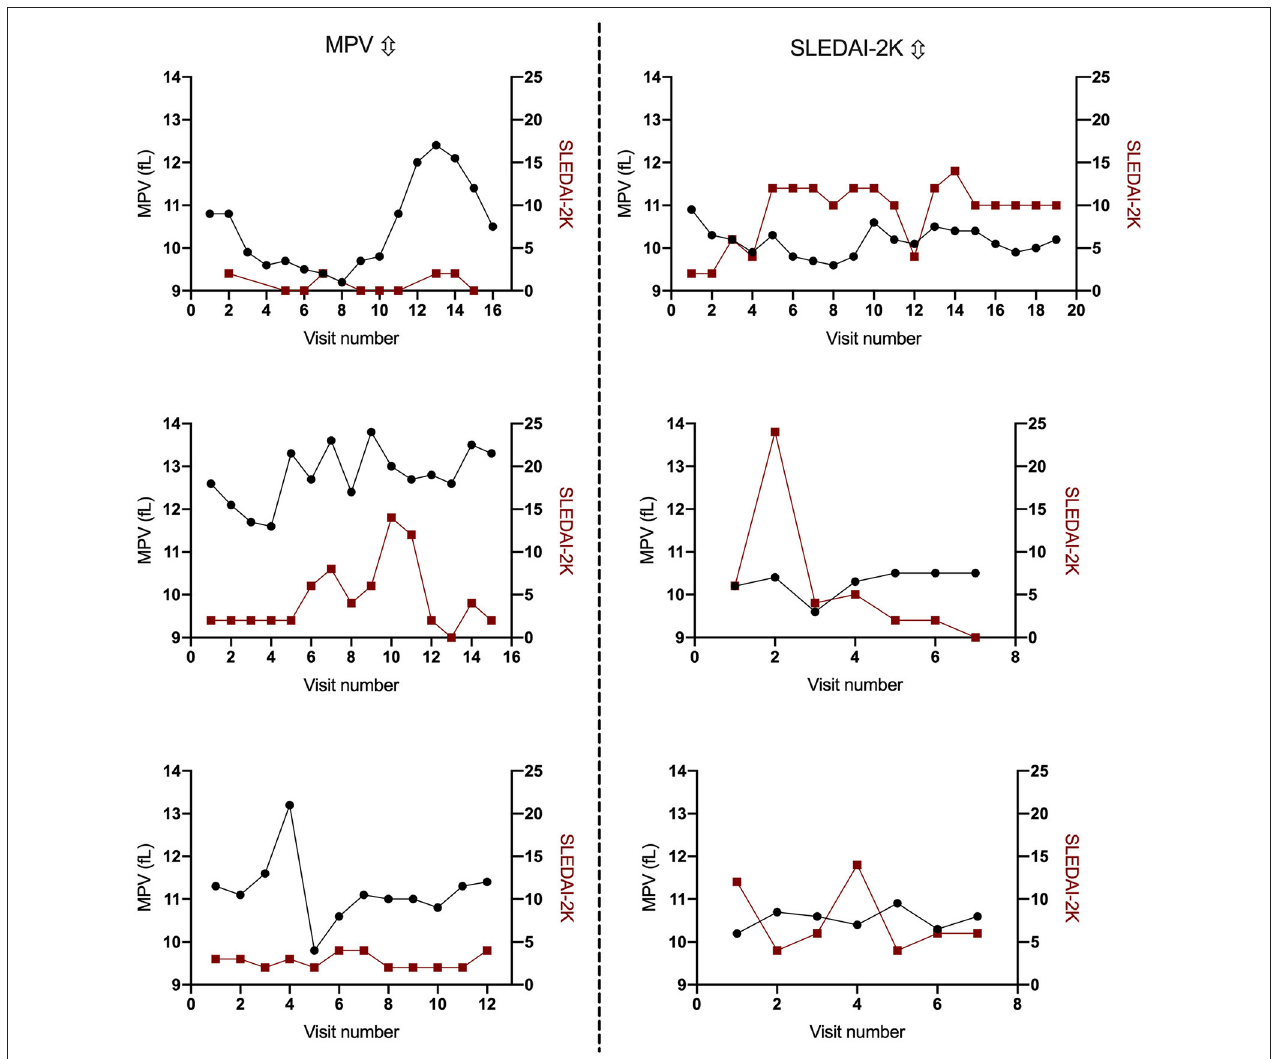
FIGURE 3 | Examples of patients with larger fluctuations in mean platelet volume (MPV) or disease activity (SLEDAI-2K). The left three graphs illustrate patients with larger MPV fluctuations and the right three graphs illustrate patients with larger fluctuations in disease